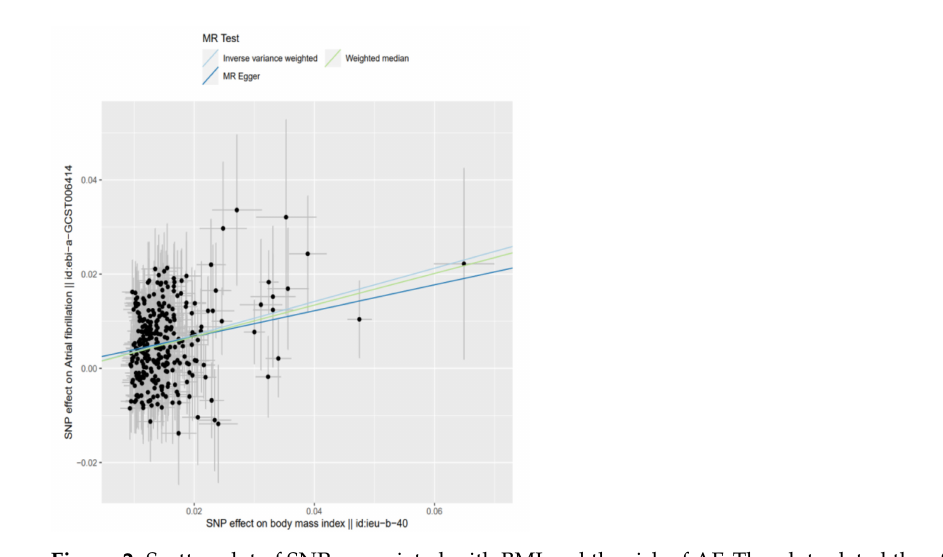
Figure 2. Scatter plot of SNPs associated with BMI and the risk of AF. The plot related the effect sizes of the SNP − BMI association ( x − axis, SD units) and the SNP − AF associations ( y − axis, log (OR)) with 95% confidence intervals. The regression slopes of the lines correspond to causal estimates using three Mendelian randomization methods (the inverse variance weighted method, MR-Egger regression, and weighted median estimator). Abbreviations: BMI, body mass index; AF, atrial fibrillation; MR, Mendelian randomization; SNP, single-nucleotide polymorphism.